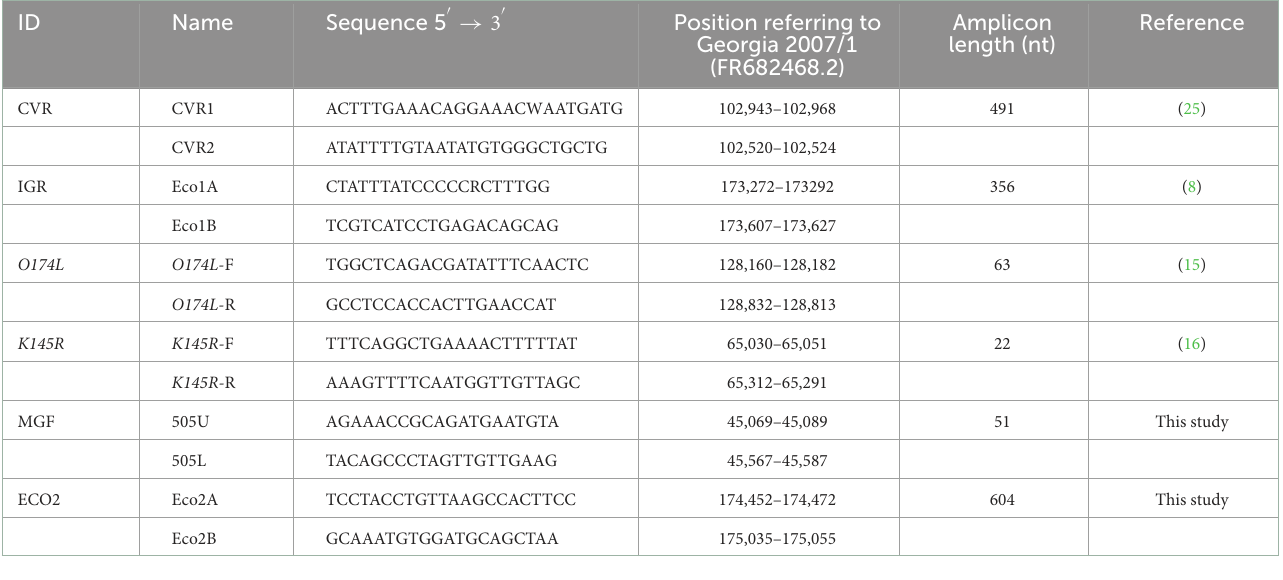
TABLE 1 Characteristics of the primers used in the study.